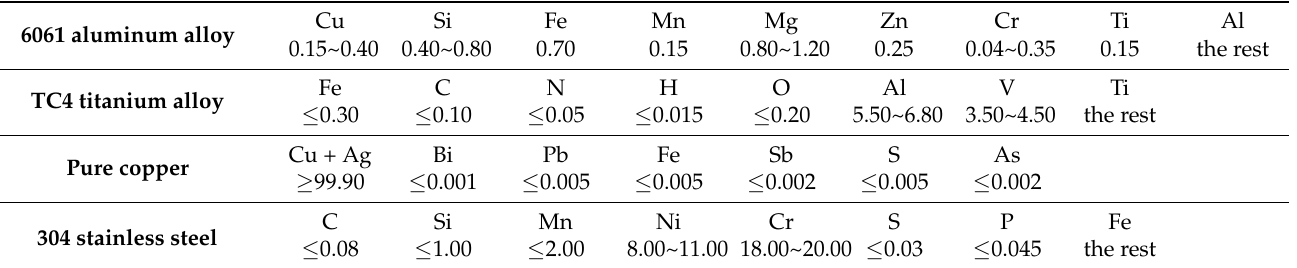
Table 1. The chemical composition of materials (mass fraction, %).